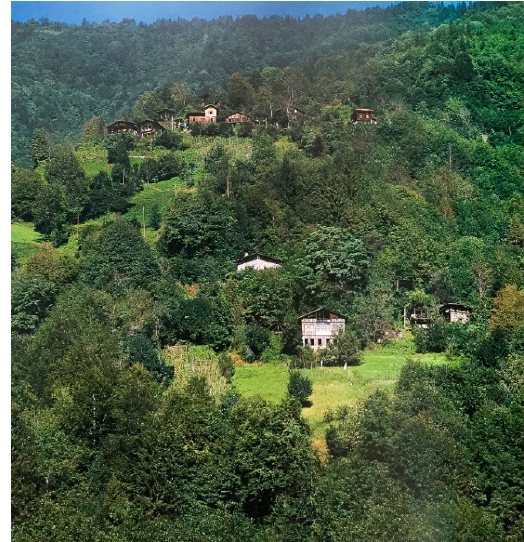
Figure 2. Houses hiding in nature (Gür and Batur 2005).